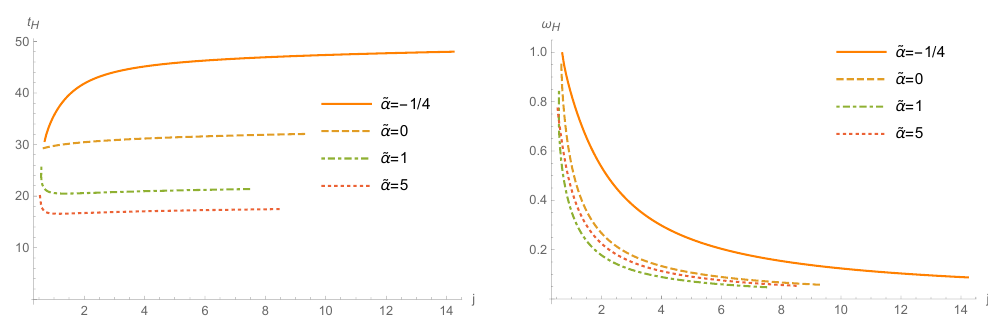
Figure 3 . The ( j; t H ) (left panel) and ( j; ! H ) (right panel) phase diagrams of the large D EGB black ring solution. As with (cid:12)gure 2, n = 30 and R runs from 1 : 1 to 20. with R if ~ (cid:11) > 0 but increases with R if (cid:0) 1 = 2 < ~ (cid:11) < 0. The right panel of (cid:12)gure 3 is the phase diagrams of ( j; ! ). On the one hand the horizon angular velocity (3.24) of the H EGB black ring is always lower than that of the Einstein black ring solution if ~ (cid:11) > 0 but higher if (cid:0) 1 = 2 < ~ (cid:11) < 0. On the other hand, as we mentioned before when ~ (cid:11)